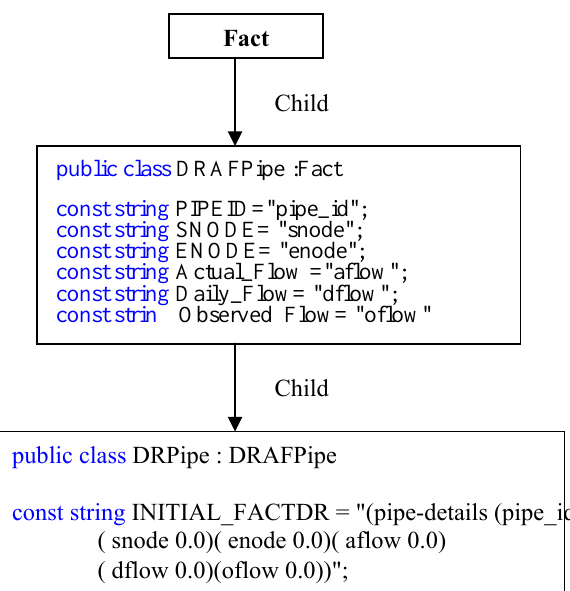
Figure 4. Class and child Class for fact of Pipe Fig. 4. Class and child Class for fact of Pipe object Fig. 4. Class and child Class for fact of Pipe object